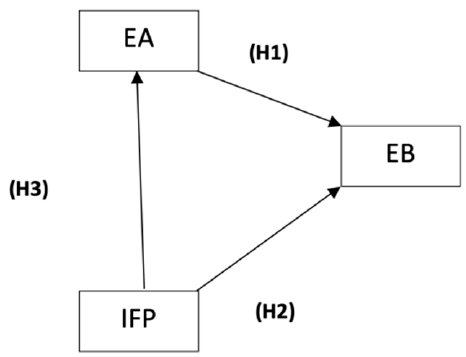
Figure 1. Conceptual model of the effects of ecological awareness (EA) and influence on food preferences (IFP) on the ecological behavior (EB). Source: own case study.